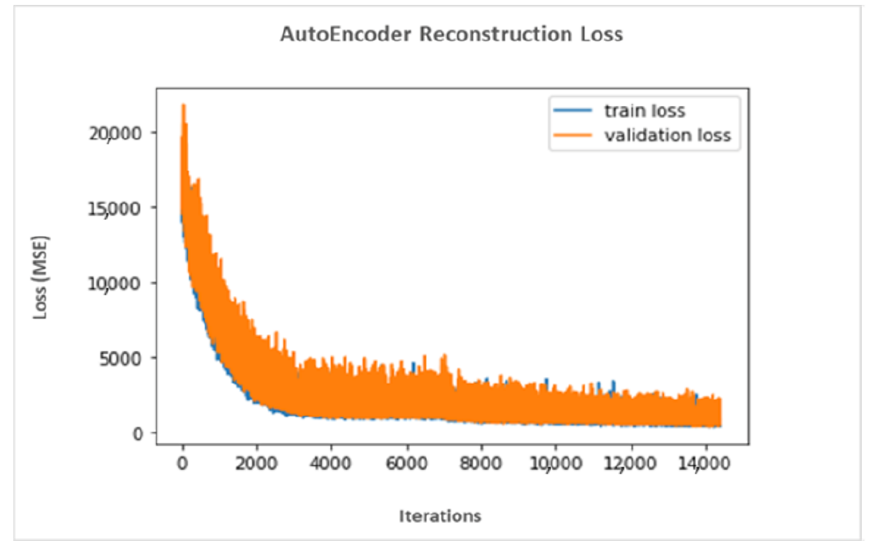
Figure 11. Reconstruction loss associated with an autoencoder.